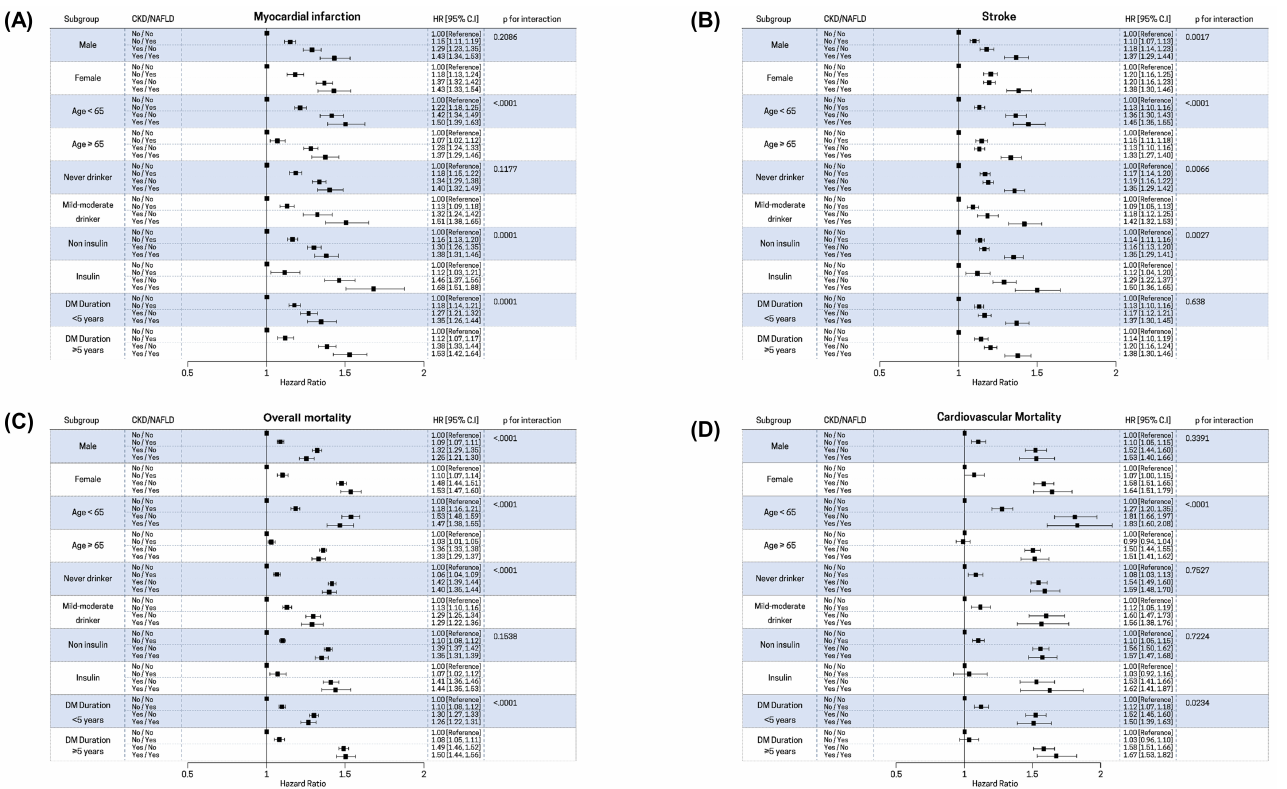
Figure 2. Forest plot showing the HRs of the association between CKD/NAFLD and ( A ) incidence of myocardial infarction, ( B ) stroke, ( C ) overall mortality, and ( D ) cardiovascular mortality in different subgroups: male vs. female; age < 65 vs. ≥ 65 years; never drinker vs. mild-moderate drinker; no-insulin vs. insulin use and DM duration < 5 years vs. DM duration ≥ 5 years. Adjusted for age, sex, income, alcohol consumption, smoking, regular exercise, income, diabetes mellitus, hypertension, dyslipidemia, DM duration, insulin use, and OHA use. HRs are represented by black squares; 95% CIs are denoted by horizontal whiskers. Abbreviations: CI, confidence interval; HR, hazard ratio; CKD chronic kidney disease; DM, diabetes; NAFLD, nonalcoholic fatty liver